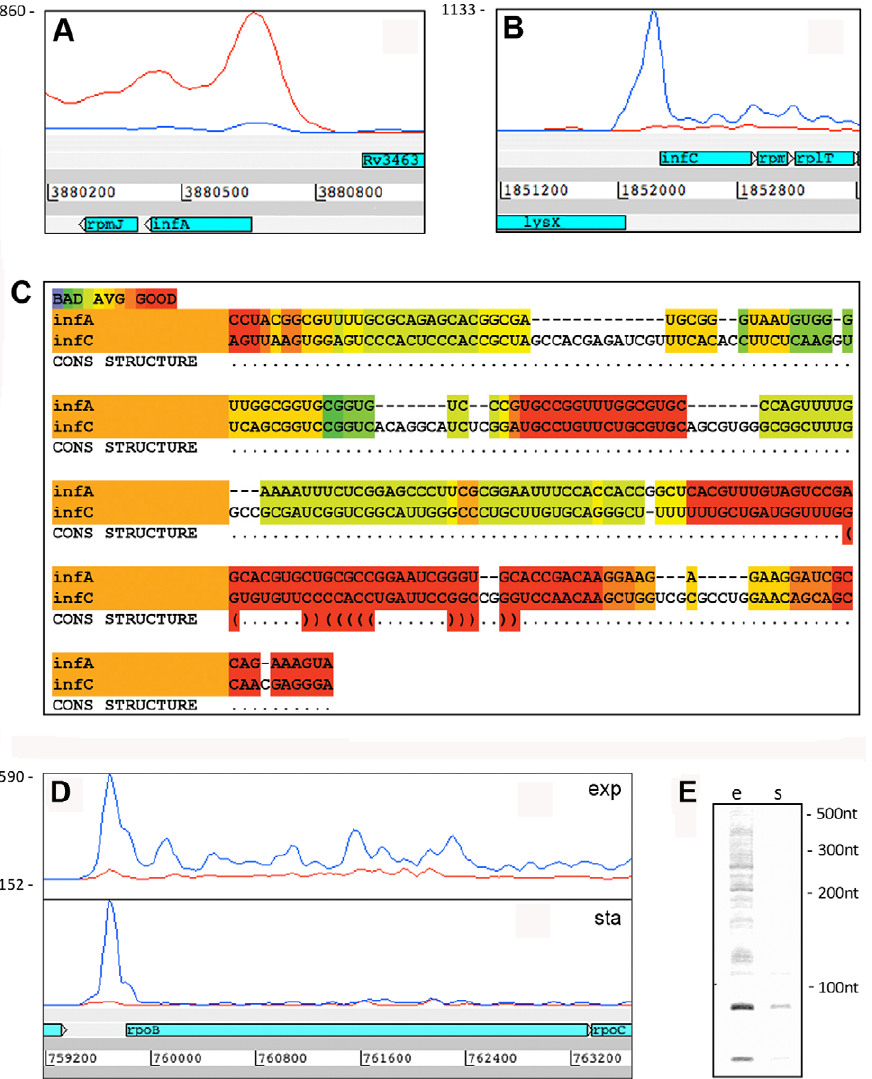
Figure 5. 5’ UTRs from genes involved in transcription and translation. Panels A and B show Artemis profiles of the 5’ UTRs of the infA and infC genes encoding translation initiation factors. Panel C is a T-coffee consensus alignment of these two 5’ UTRs generated using the WAR webserver (http://genome.ku.dk/resources/war) [40]. The alignment is based on the consensus from four independent alignment approaches, and shows significant homology in several regions (key to the degree of alignment is shown in the top left corner of the panel). The 5’ UTR homologies are consistent with a common recognition site involved in coordinate regulation. Panels D and E illustrate analysis of the 5’ UTR of rpoB by Artemis profiling and Northern blotting of samples from exponential (‘‘e’’) and stationary (‘s’’) growth phases. The 5’ UTR of rpoB remains prominent in stationary phase, in contrast to decreased expression of the CDS.